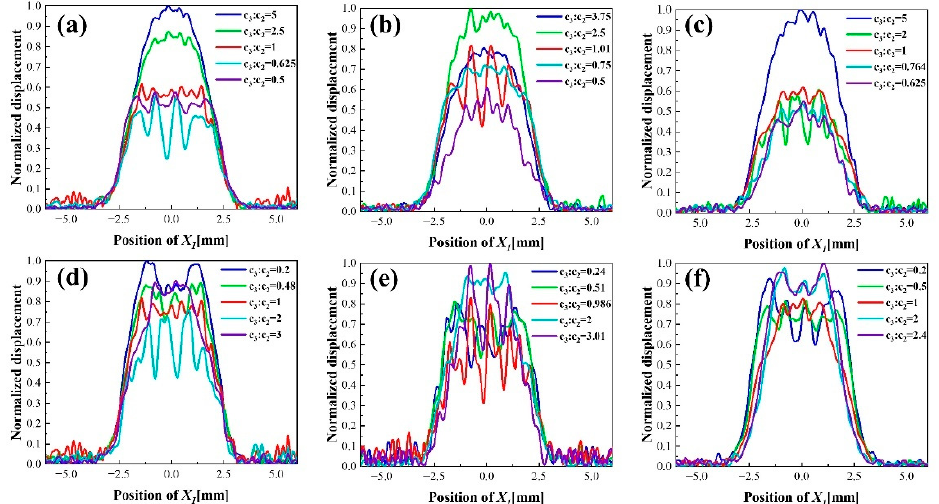
Figure 6. Normalized displacement distribution in 𝑋 (cid:2869) direction on electric shaft 𝑋 (cid:2869) of dot double- finger electrode: ( a – c ) Fixed dot electrode radius c 3 is 0.25 mm, 0.375 mm, 0.5 mm with different ratio finger electrode: ( a – c ) Fixed dot electrode radius 𝑐 (cid:2871) is 0.25 mm, 0.375 mm, 0.5 mm with different of c 3 to c 2 ; ( d – f ) Fixed gap width c 2 is 0.25 mm, 0.375 mm, 0.5 mm with different ratio of c 3 to c 2 ratio of 𝑐 (cid:2871) to 𝑐 (cid:2870) ; ( d – f ) Fixed gap width 𝑐 (cid:2870) is 0.25 mm, 0.375 mm, 0.5 mm with different ratio of 𝑐 (cid:2871) to 𝑐 (cid:2870) .